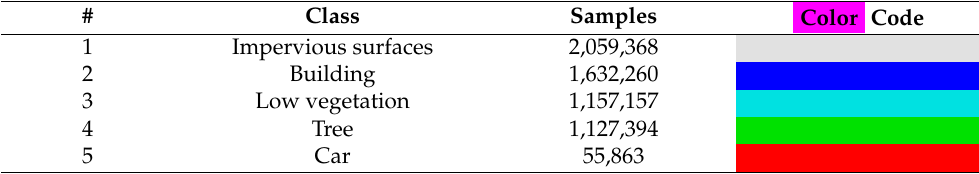
Table 8. The population of samples in the Vaihingen